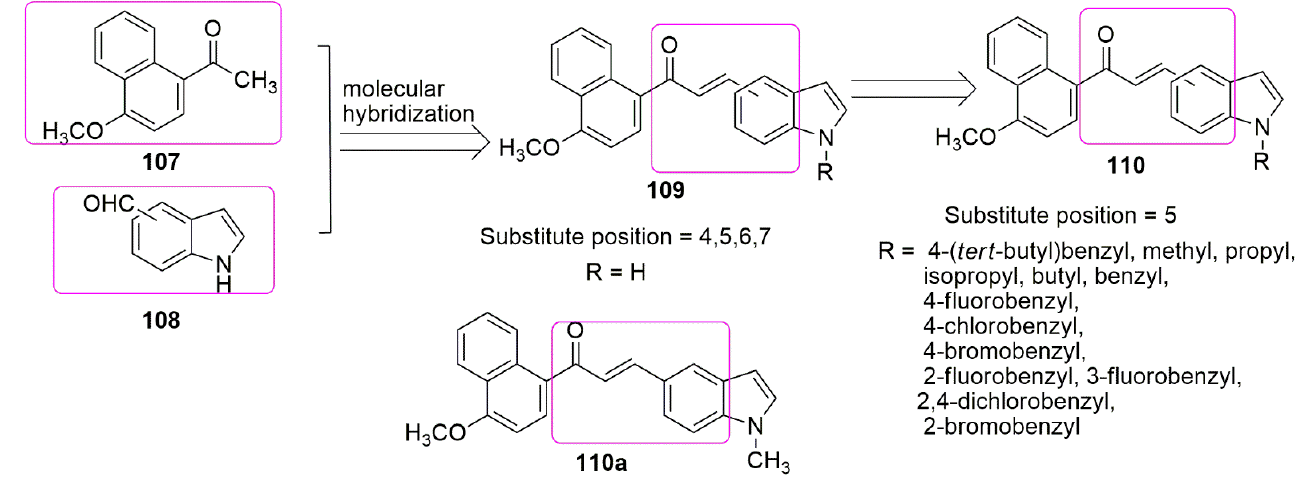
Figure 32. Chalcone derivatives containing indole and naphthalene moieties.